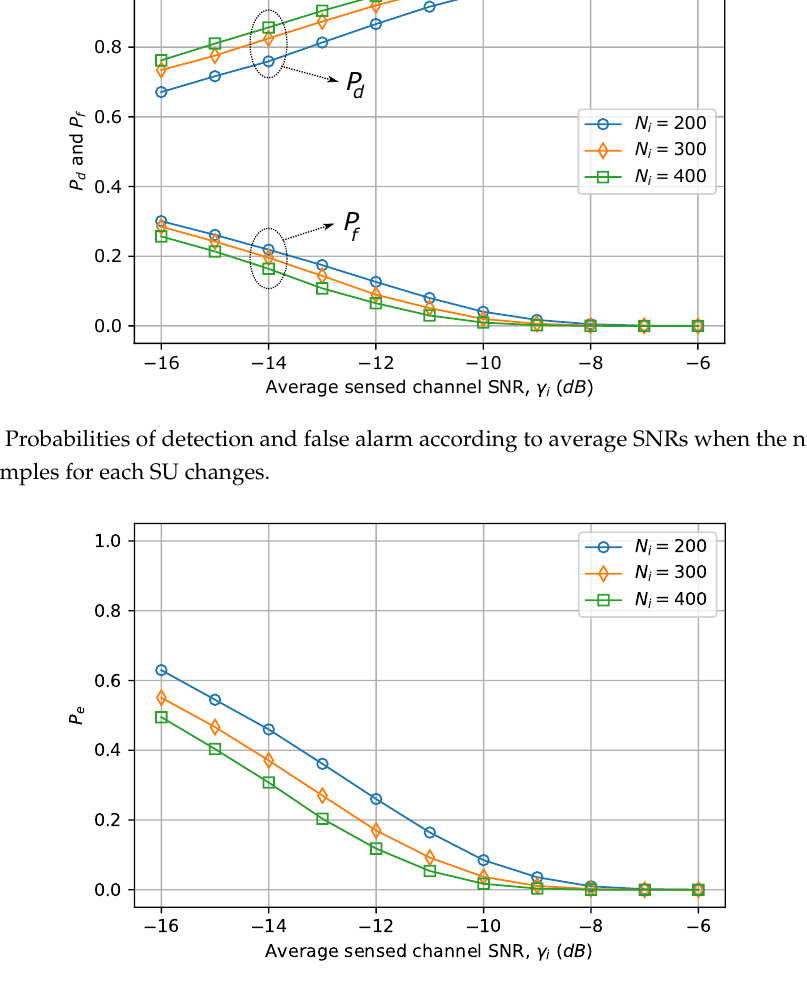
Figure 12. Sensing error according to average SNRs when the number of sensing samples for each SU, N ,